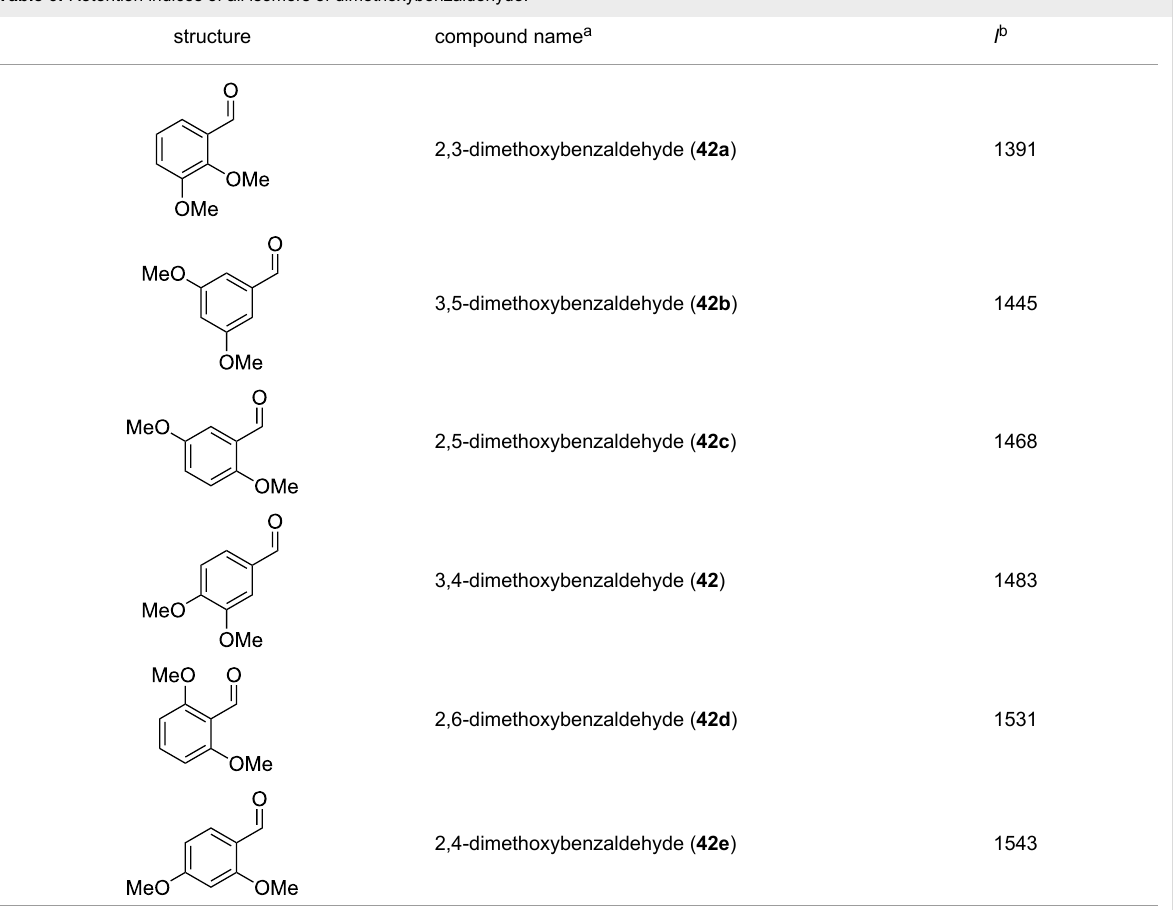
Table 6: Retention indices of all isomers of